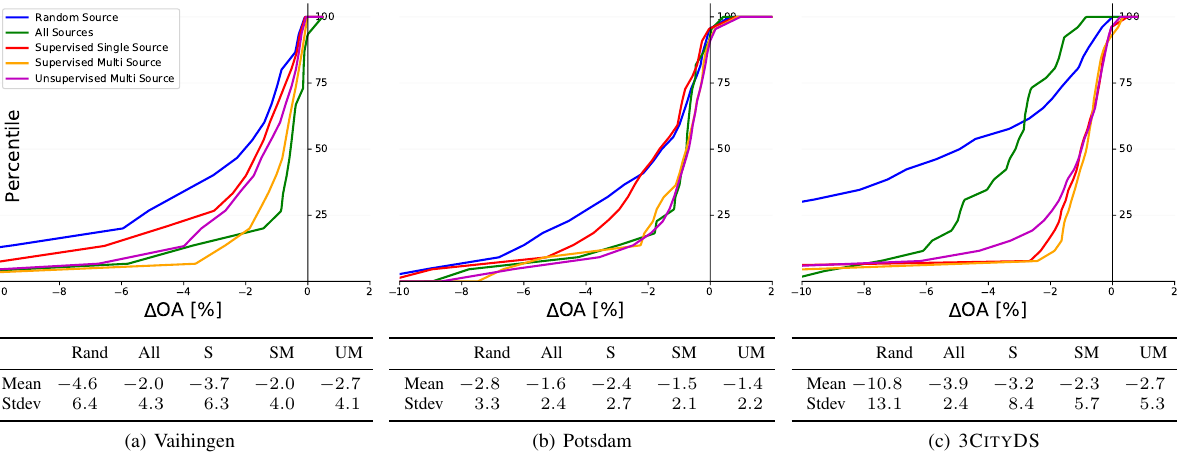
Figure 4. Source selection results. ∆ OA : difference in OA compared to a classifier based on target training data. Example for interpretation (Vaihingen, All Sources ): for 25% of the target patches the loss in OA is larger than 1% ( ∆ OA < -1%). that is comparable to the other datasets by multi-source